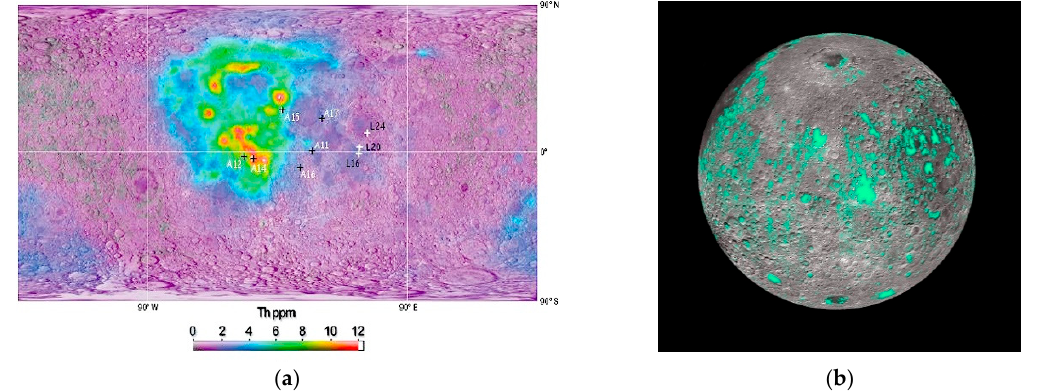
Figure 6. ( a ) Map showing thorium concentrated in the area of Imbrium impact basin, but also widely distributed on the front side of Moon (central half of diagram), including Apollo landing sites. ( b ) Lunar global image showing mapping of “light plains” in patterns radial to Orientale impact basin (at top) and interpreted as deposits of uncertain character associated with the formation of Orientale (Meyer et al. 2018 [65]). This image supports the very widespread distribution of surface materials associated with an Imbrium-sized basin (Courtesy Heather Meyer).